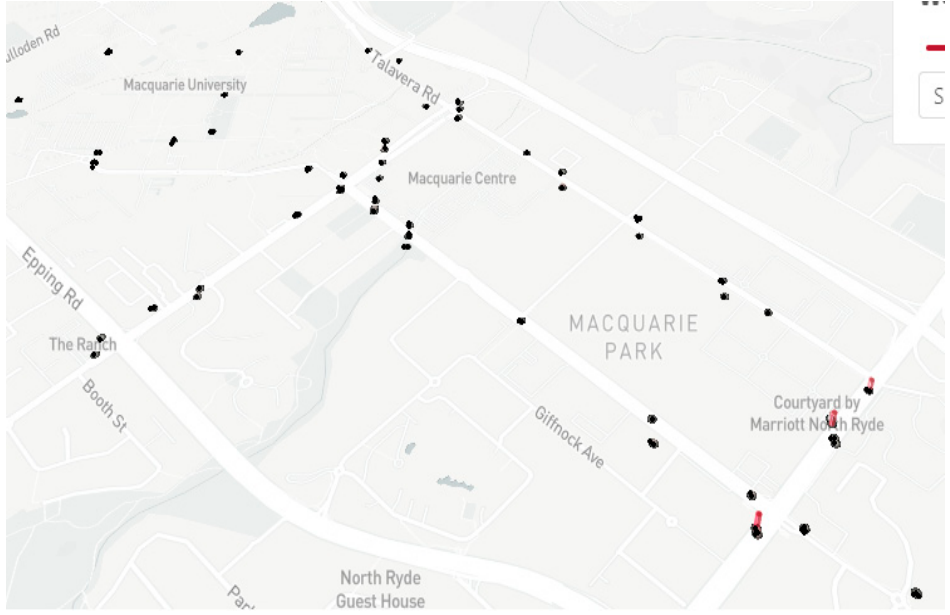
Figure 7. Study locations of the proposed sensor node.